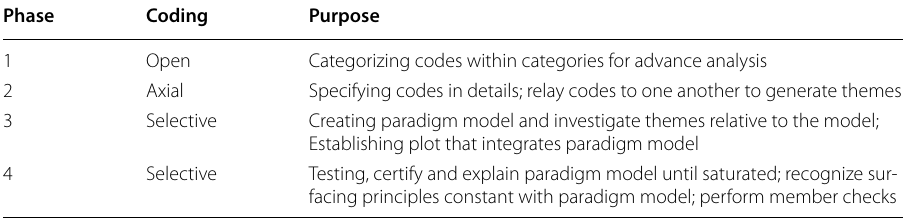
Table 2 Four-stage data analyzing strategy